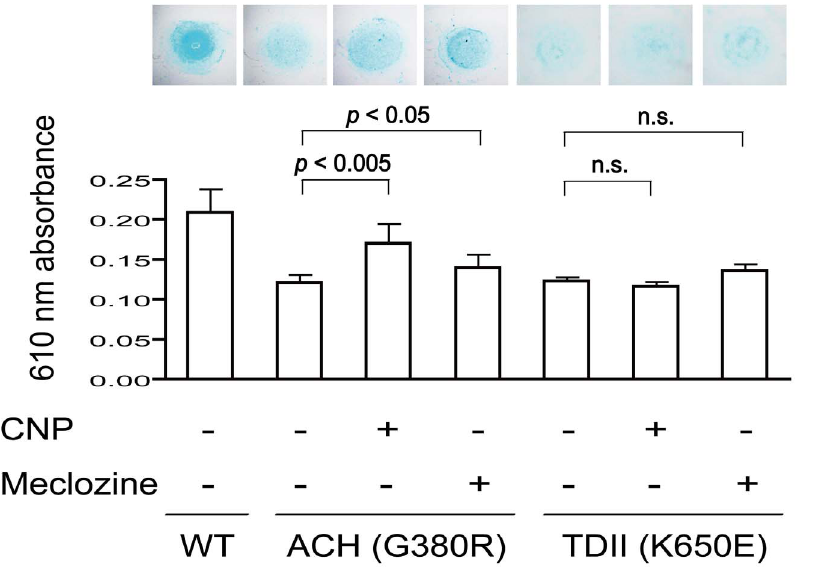
Figure 3. Meclozine facilitates chondrocyte differentiation of ATDC5 cells expressing mutant FGFR3 in micromass culture. ATDC5 cells were infected with lentivirus expressing FGFR3-WT (wild-type), FGFR3-G380R causing ACH, or FGFR3-K650E causing TDII. Similar expressions of the transgenes are shown by immunoblotting in Figure S3. ATDC5 cells in micromass culture were treated with CNP (0.2 m M) or meclozine (20 m M) for six days and were stained with Alcian blue. Experiments were repeated six times and representative images are shown. After staining, matrix proteoglycans in the cell lysate were quantified by measuring absorbance at 610 nm. The data are presented as the mean and SD ( n =6). CNP and meclozine increased the Alcian blue staining of ATDC5 cells expressing FGFR3-G380R and –K650E in micromass culture. Statistical significance is